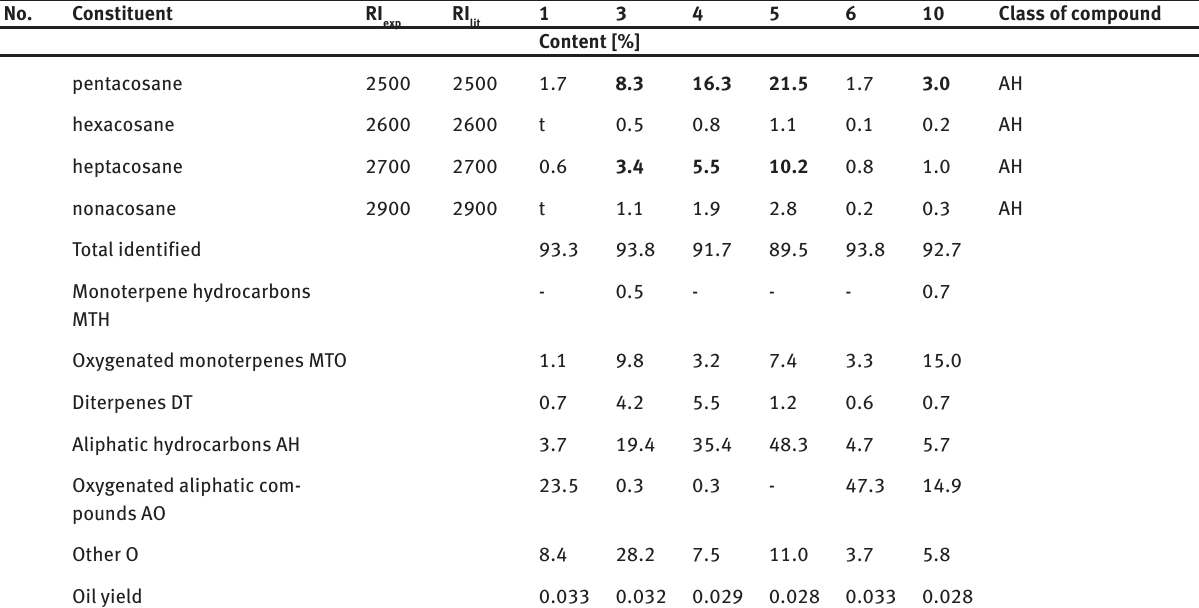
, experimental retention index; RI , literature retention index; t, trace – exp lit